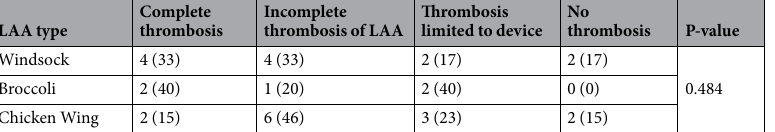
Table 2. Level of LAA thrombosis depending on different LAA morphologies. Values are total numbers (percentage). Analysis of contingency tables by Fishers’s exact test p-value = 0.484 revealed no significant difference.